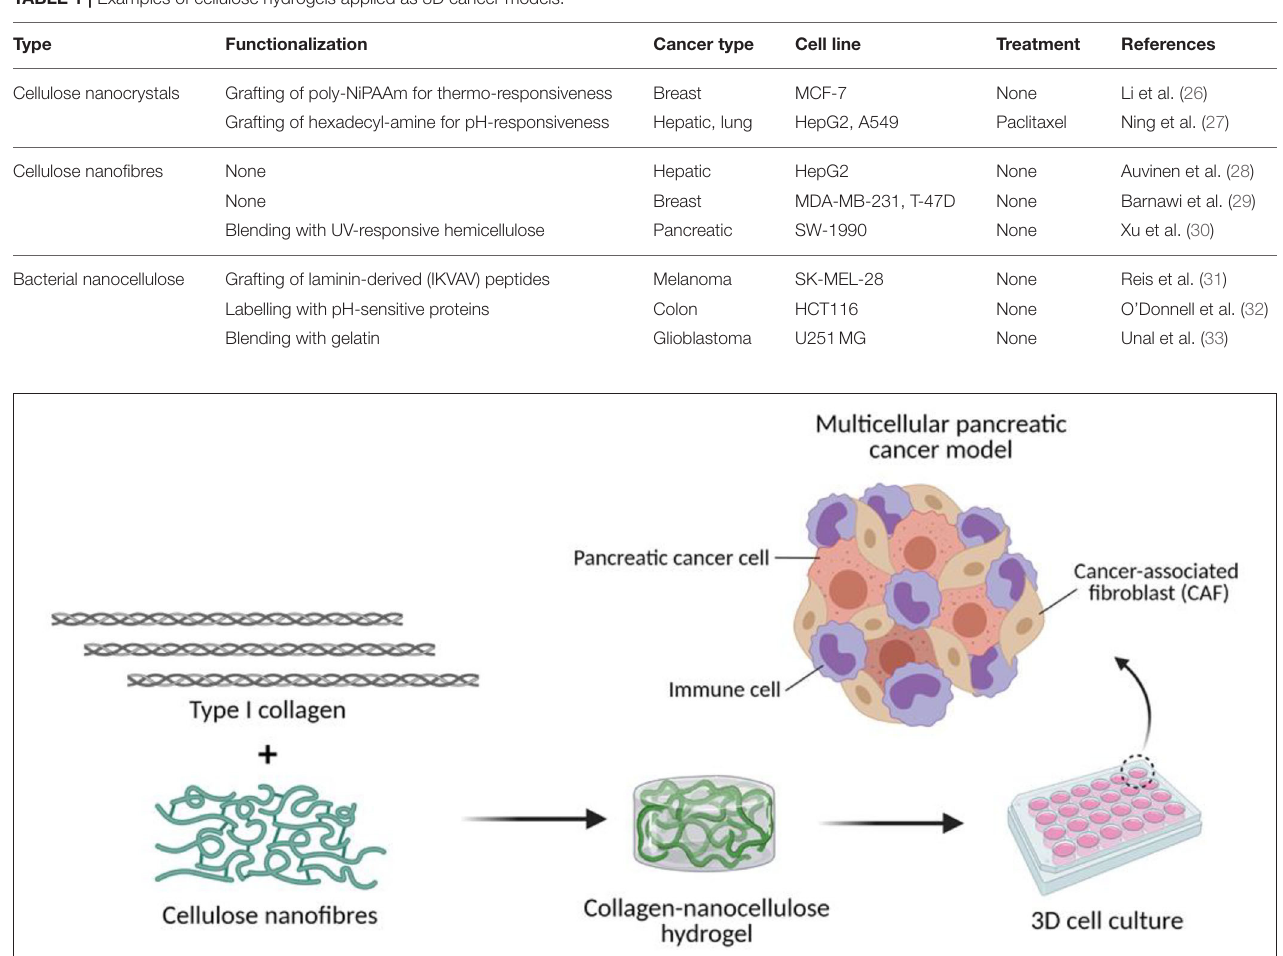
FIGURE 1 | Engineering the TME of pancreatic cancer with collagen-nanocellulose hydrogels. Type I collagen fibrils and cellulose nanofibres are blended to form hydrogels that support the growth of multiple cell populations found in pancreatic cancer tissues.